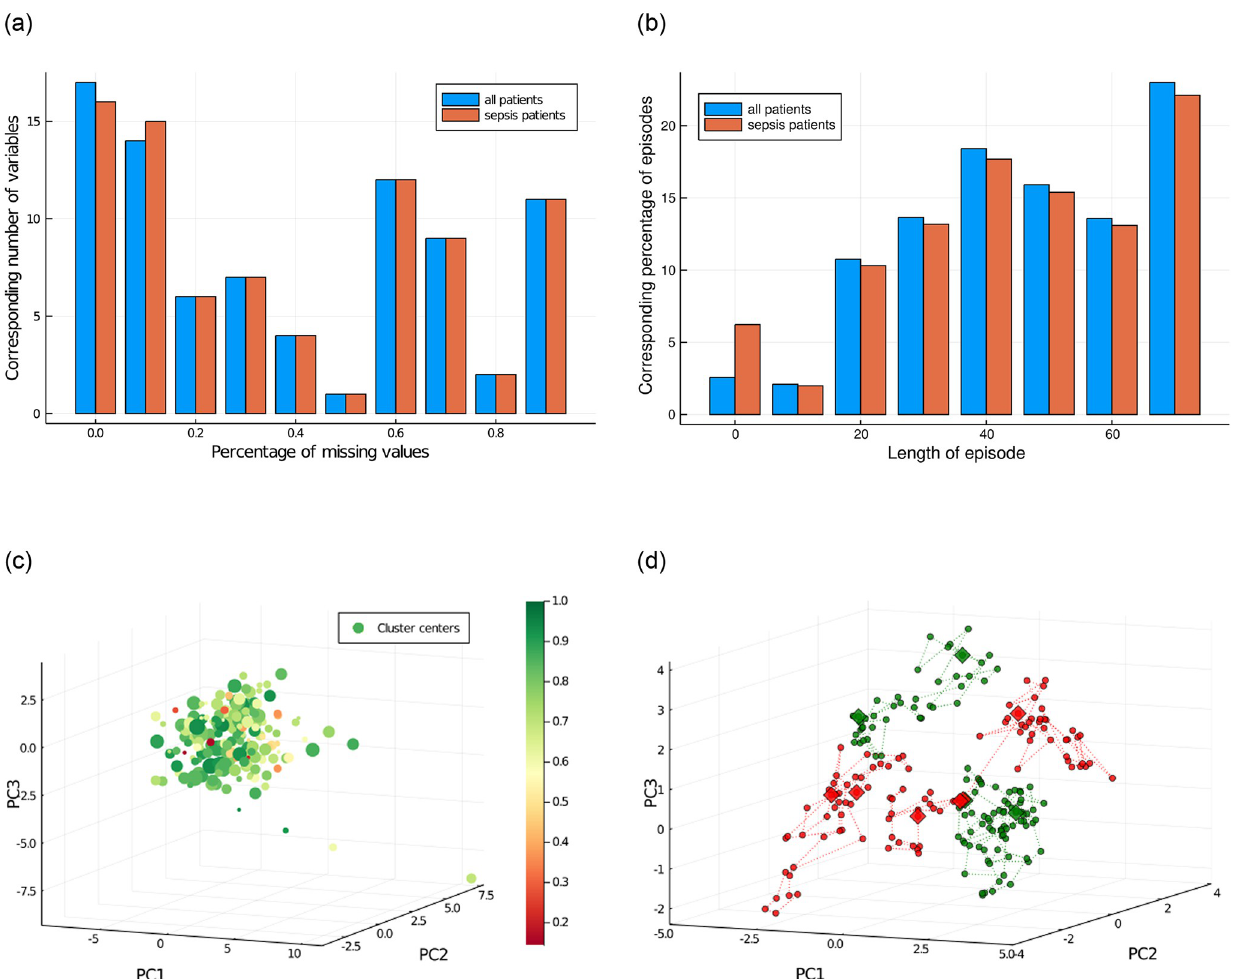
Fig 2. Overview of the data. (a) Histogram for the percentage of missing values before matrix completion. Features with more than 90% missing values were not kept. It appears that missingness does not depend on sepsis diagnosis. (b) Histogram for the length (i.e. number of timesteps) of the episodes. (c) 3D representation of cluster centers, using a linear projection along the first three principal components of the data. The size of the points is affine in the population of the clusters. The color scale corresponds to the survival rate in each cluster. (d) A representation of some episodes using the linear projection along principal components. We represent in green two episodes where the patient survived and in red three episodes where the patient died within 90 days.